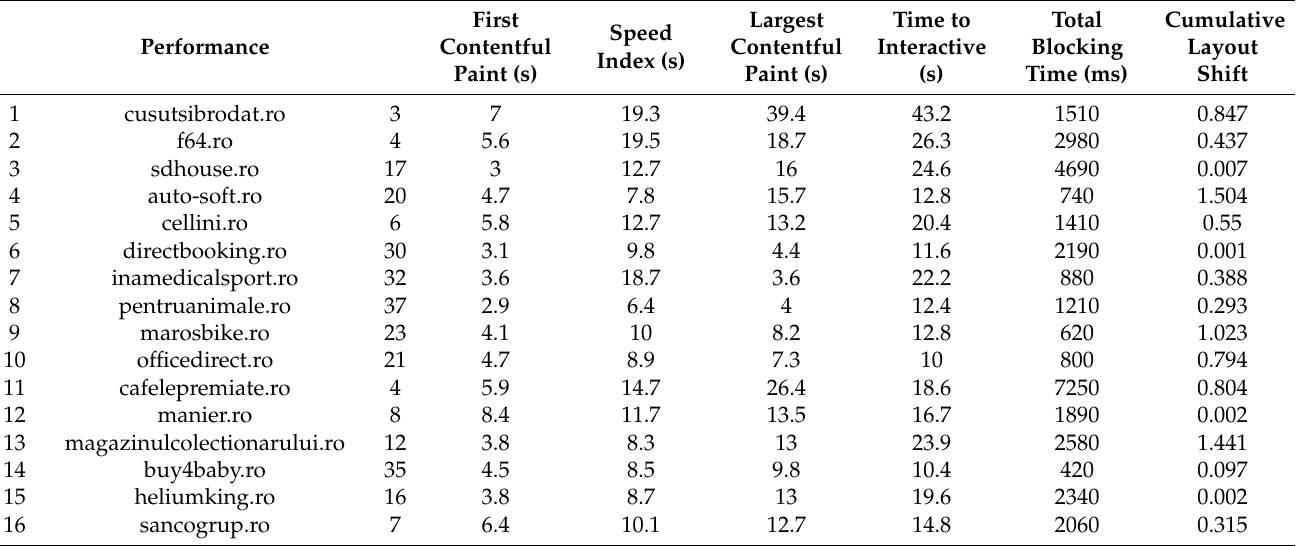
Table 2. The values of the sub-indicators calculated by web.dev.